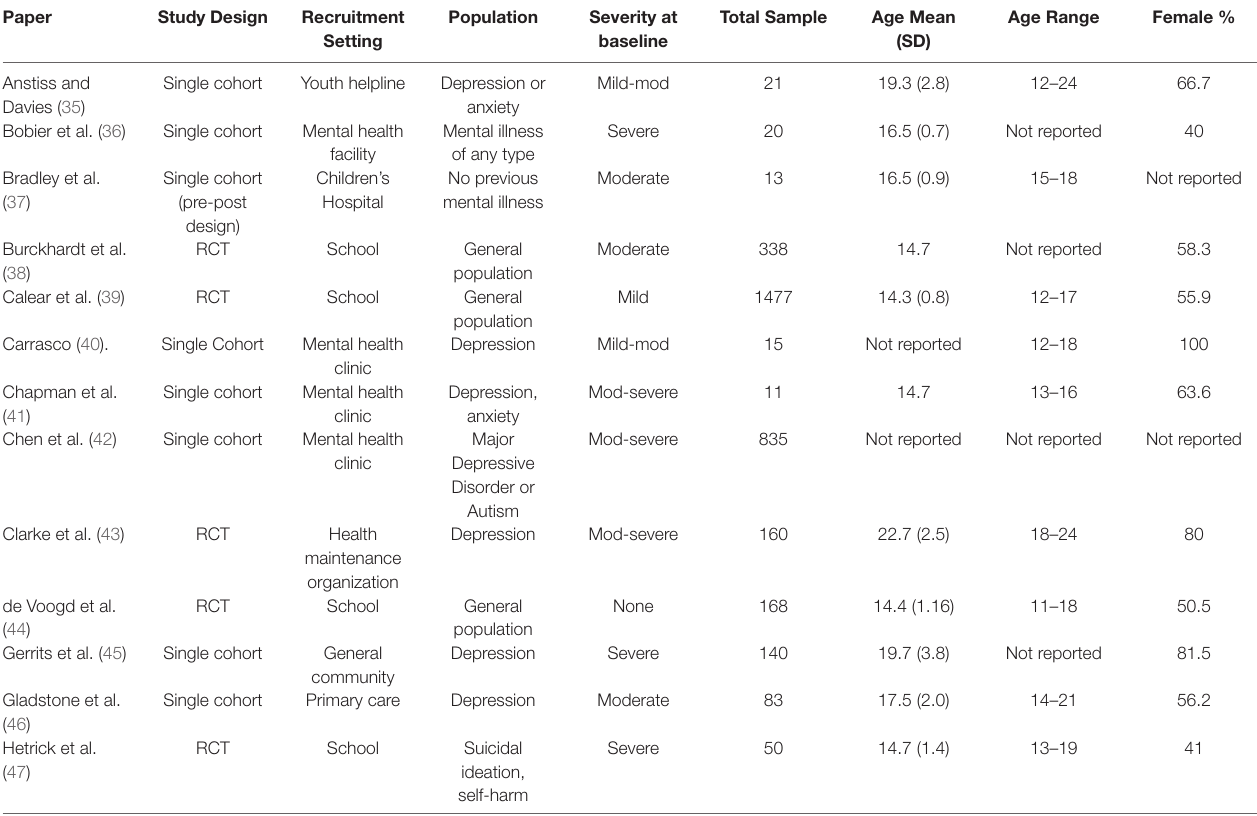
TABLE 1 | Study and Participant